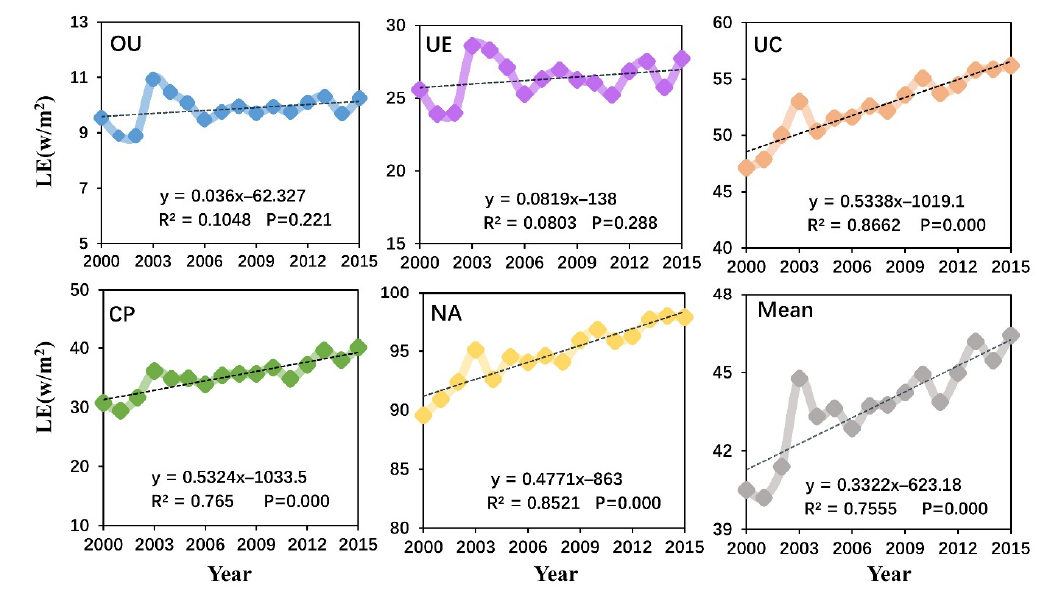
Figure 10. Latent heat flux (LE) trend under different land use types in the influence area of the YRB from 2000 to 2015.